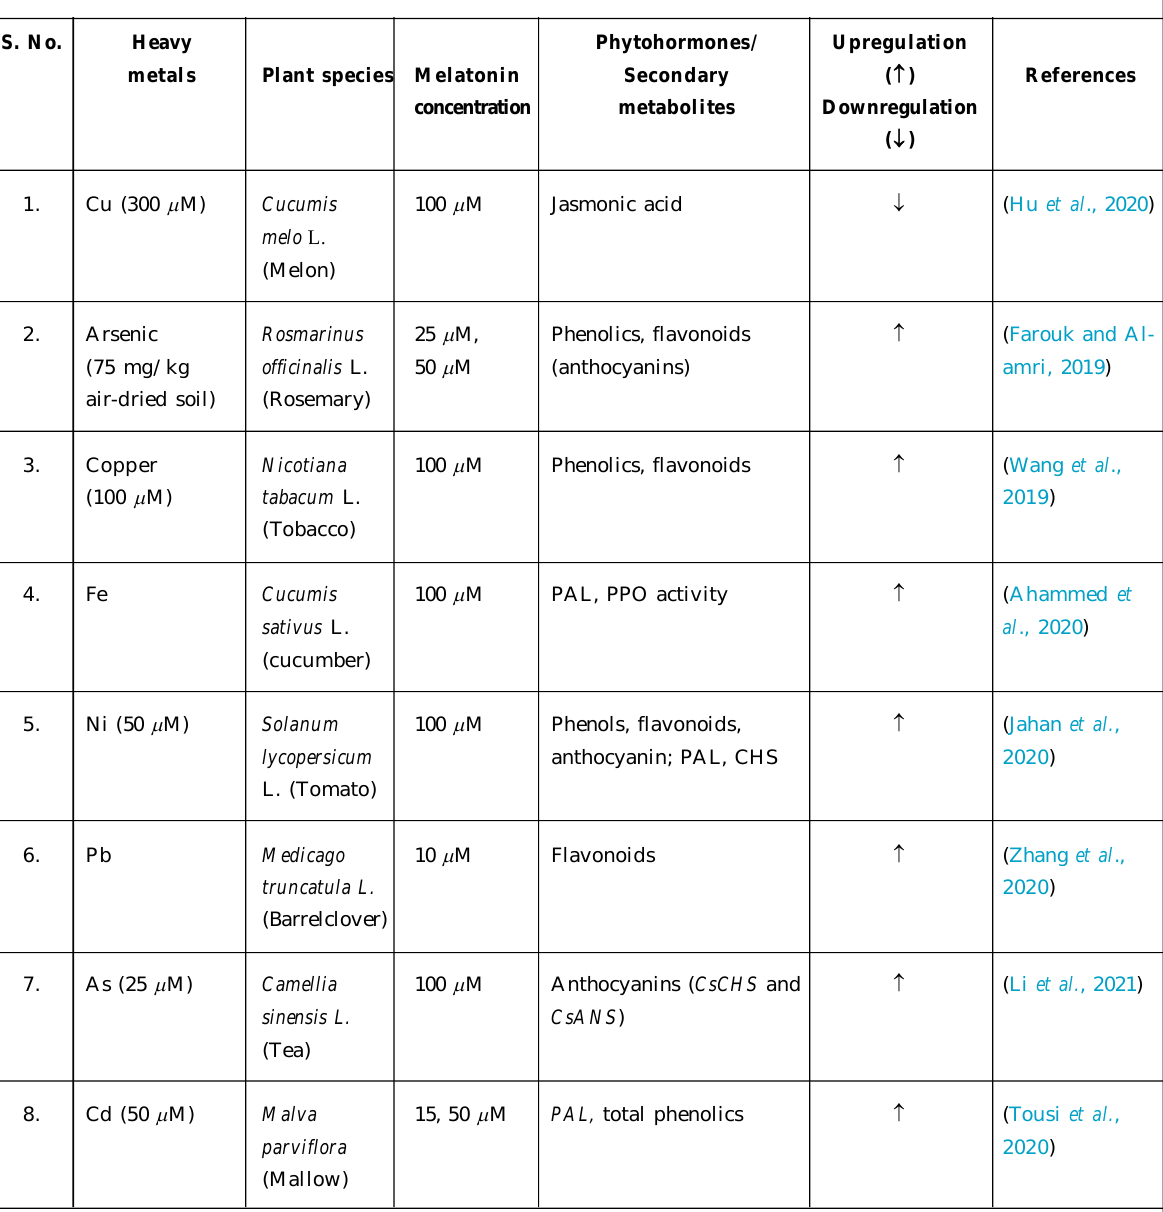
Table 3: Phytohormones/secondary metabolites along with genes/enzymes related to them that are modulated by exogenous melatonin under HM